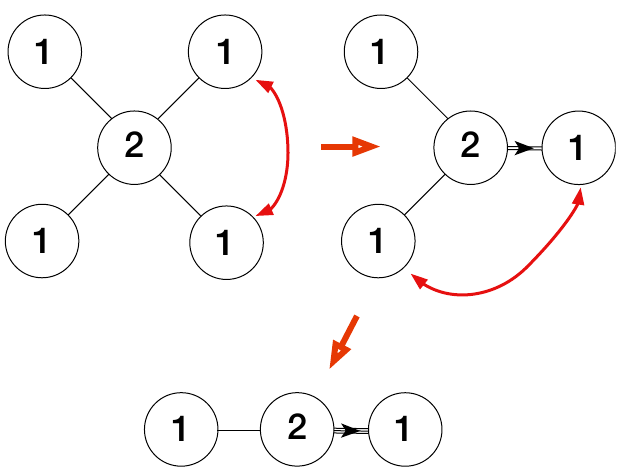
Figure 5 . Folding D 4 Dynkin diagram to B 3 Dynkin diagram, and then to G 2 Dynkin